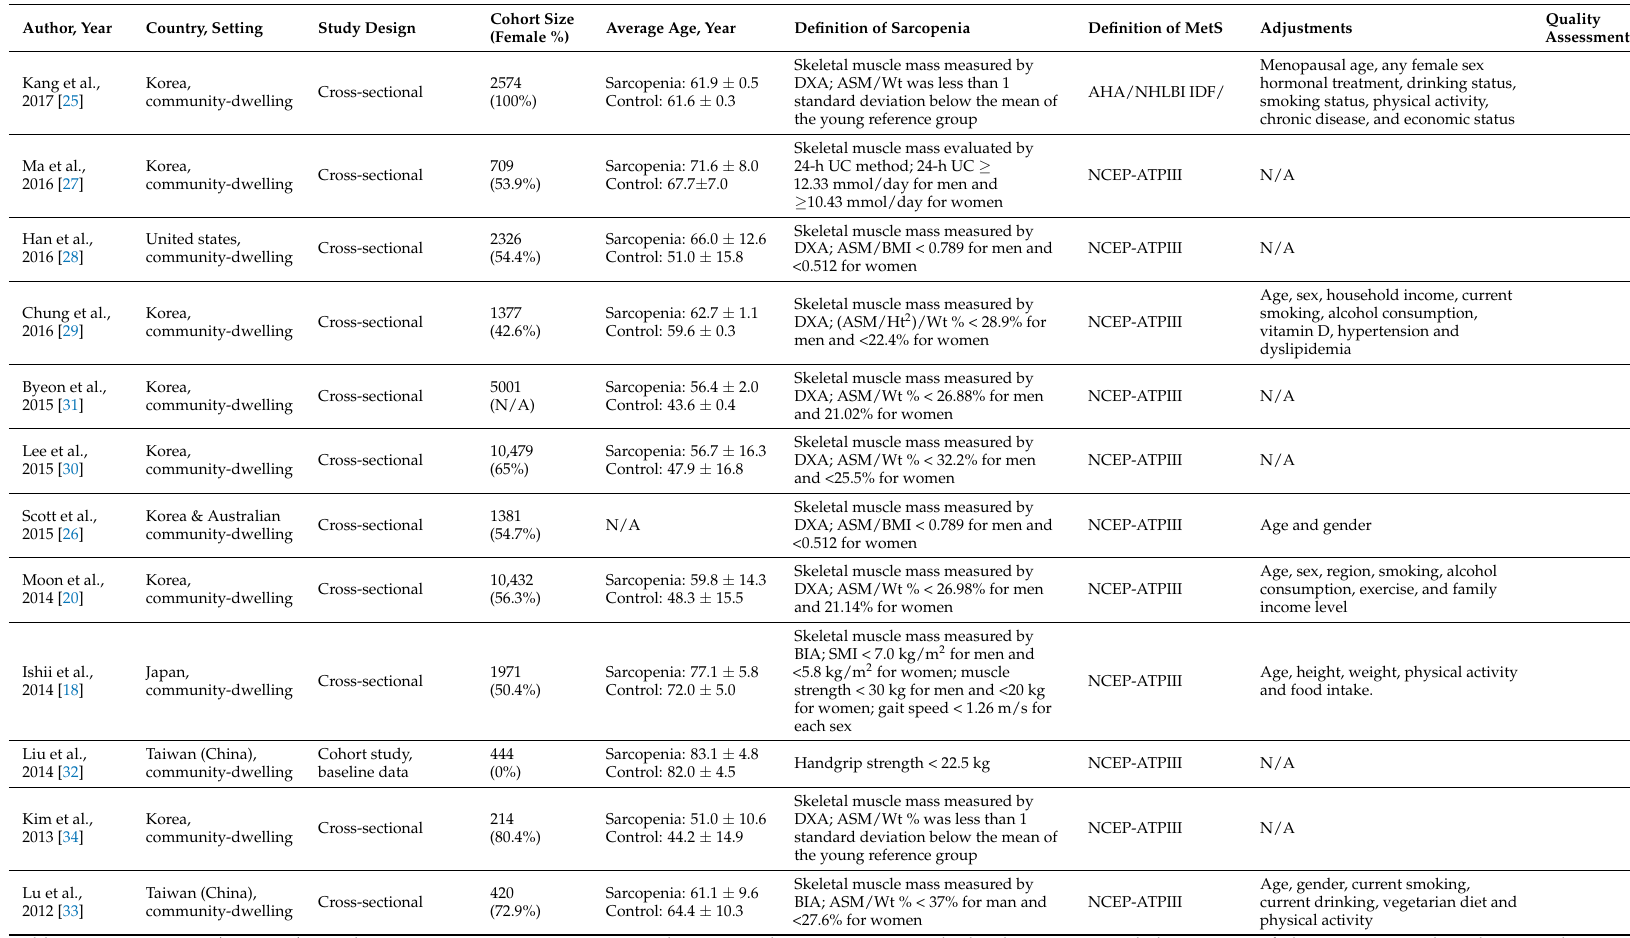
Table 1. Characteristics of included